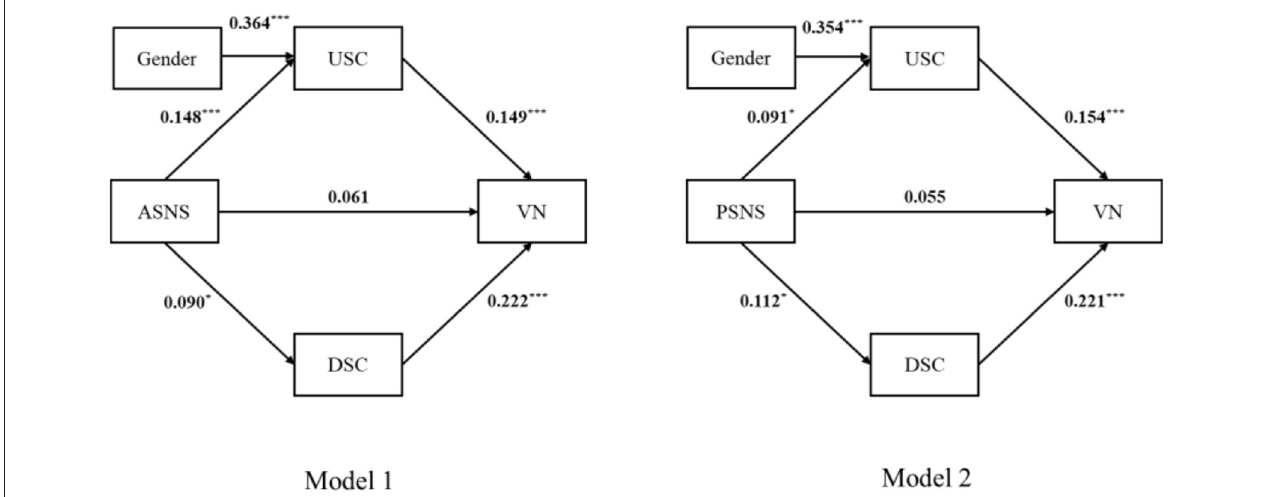
FIGURE 2 | The model of the effects of active and passive social networking site use on vulnerable narcissism; Values are standardized coefficients. * p < 0.05; ** p < 0.01; *** p < 0.001, two-tailed p for all tests; ASNS, Active social networking sites; PSNS, Passive social networking sites; USC, Upward social comparison; DSC, Downward social comparison; VN, Vulnerable narcissism. Control variable, gender.